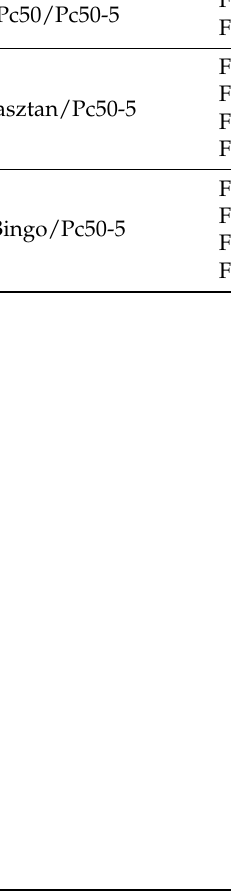
Table 3. DNA sequences used for SCAR markers design.